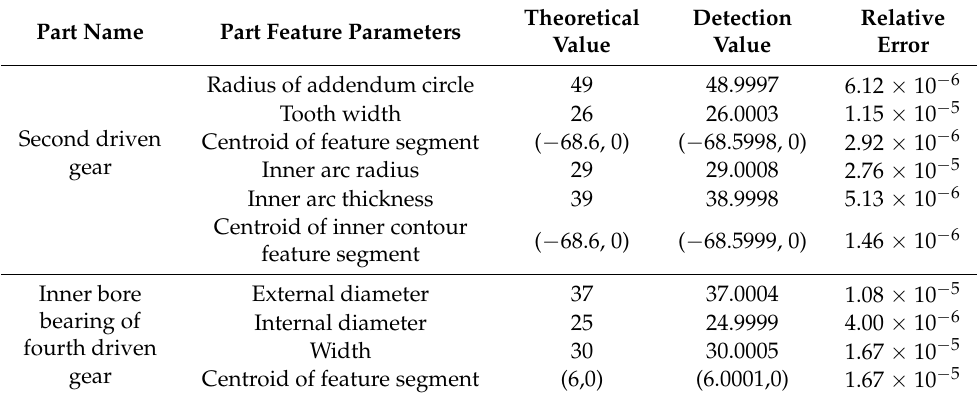
Table 4. Statistical table of error verification data.